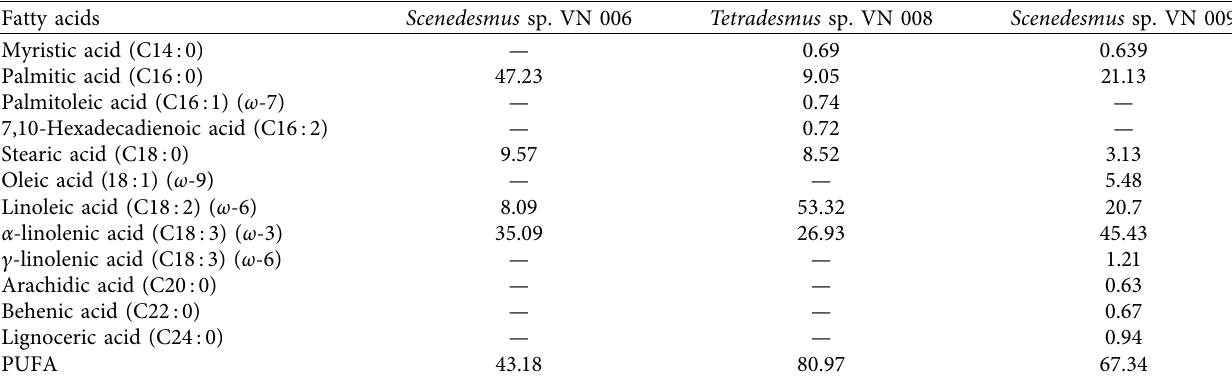
Table 6: Fatty acid composition profile for microalgal lipids from three isolates exhibiting the highest biomass